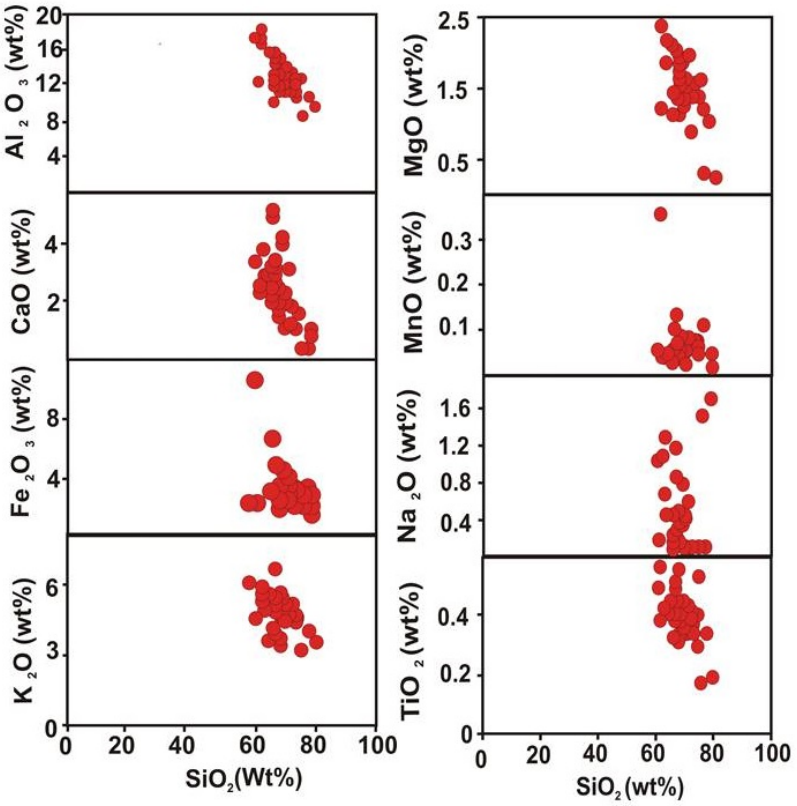
Figure 8. Harker variation diagrams for major oxides vs. SiO 2 contents for the felsic volcanic rocks from Mundiyawas-Khera area. (Data source: Table S1).